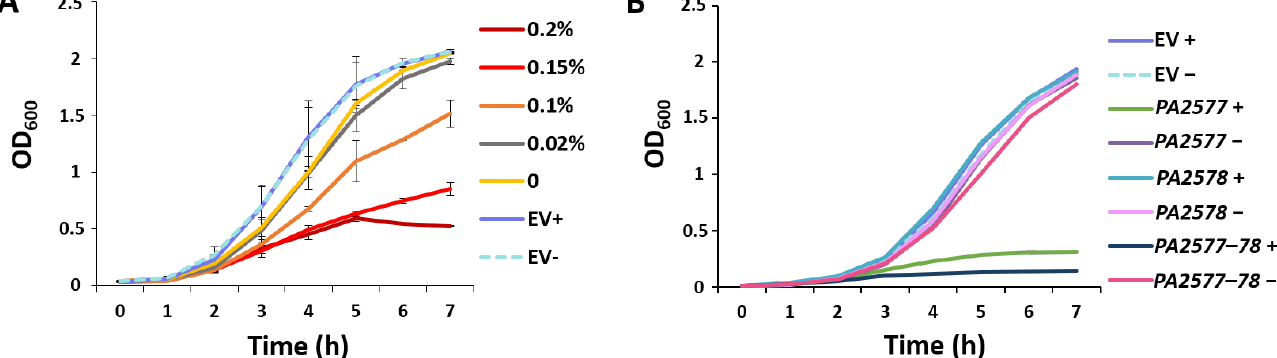
Figure 2. Effect of PA2577 excess on bacterial growth. ( A ) P. aeruginosa PAO1161 strains carrying empty vector pKGB8 araBAD p (EV) or pMEB12 araBAD p- PA2577 grown in LB under selection with the indicated gradient of inducer concentration (0 to 0.2%). The grey line indicates the growth in the presence of 0.02% arabinose—conditions selected for RNA-seq analysis. Data represent mean OD 600 from three independent replicates ± SD. ( B ) Comparison of the impact of PA2577 , PA2578 and PA2577 – PA2578 overexpression on the growth of PAO1161 cells. Strains carrying pAMB9.37 ( lacI Q - tac p; EV control), pMEB64 ( lacI Q - tac p- PA2577 ), pMEB185 ( lacI Q - tac p- PA2578 ) or pMEB186 ( lacI Q - tac p- PA2577 – 78 ) were grown in LB under selection with the addition of 0.5 mM (+) or absence ( − ) of IPTG. Data represent mean OD 600 from three independent replicates, SD are not shown for clarity.